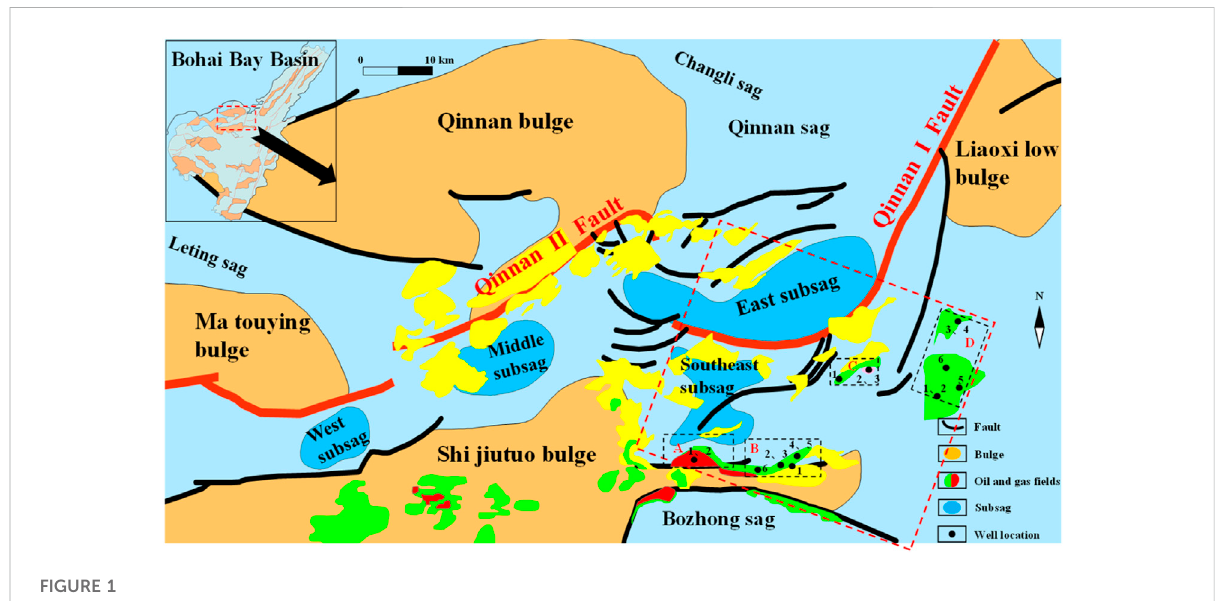
FIGURE 1 Structural geological map of Qinnan